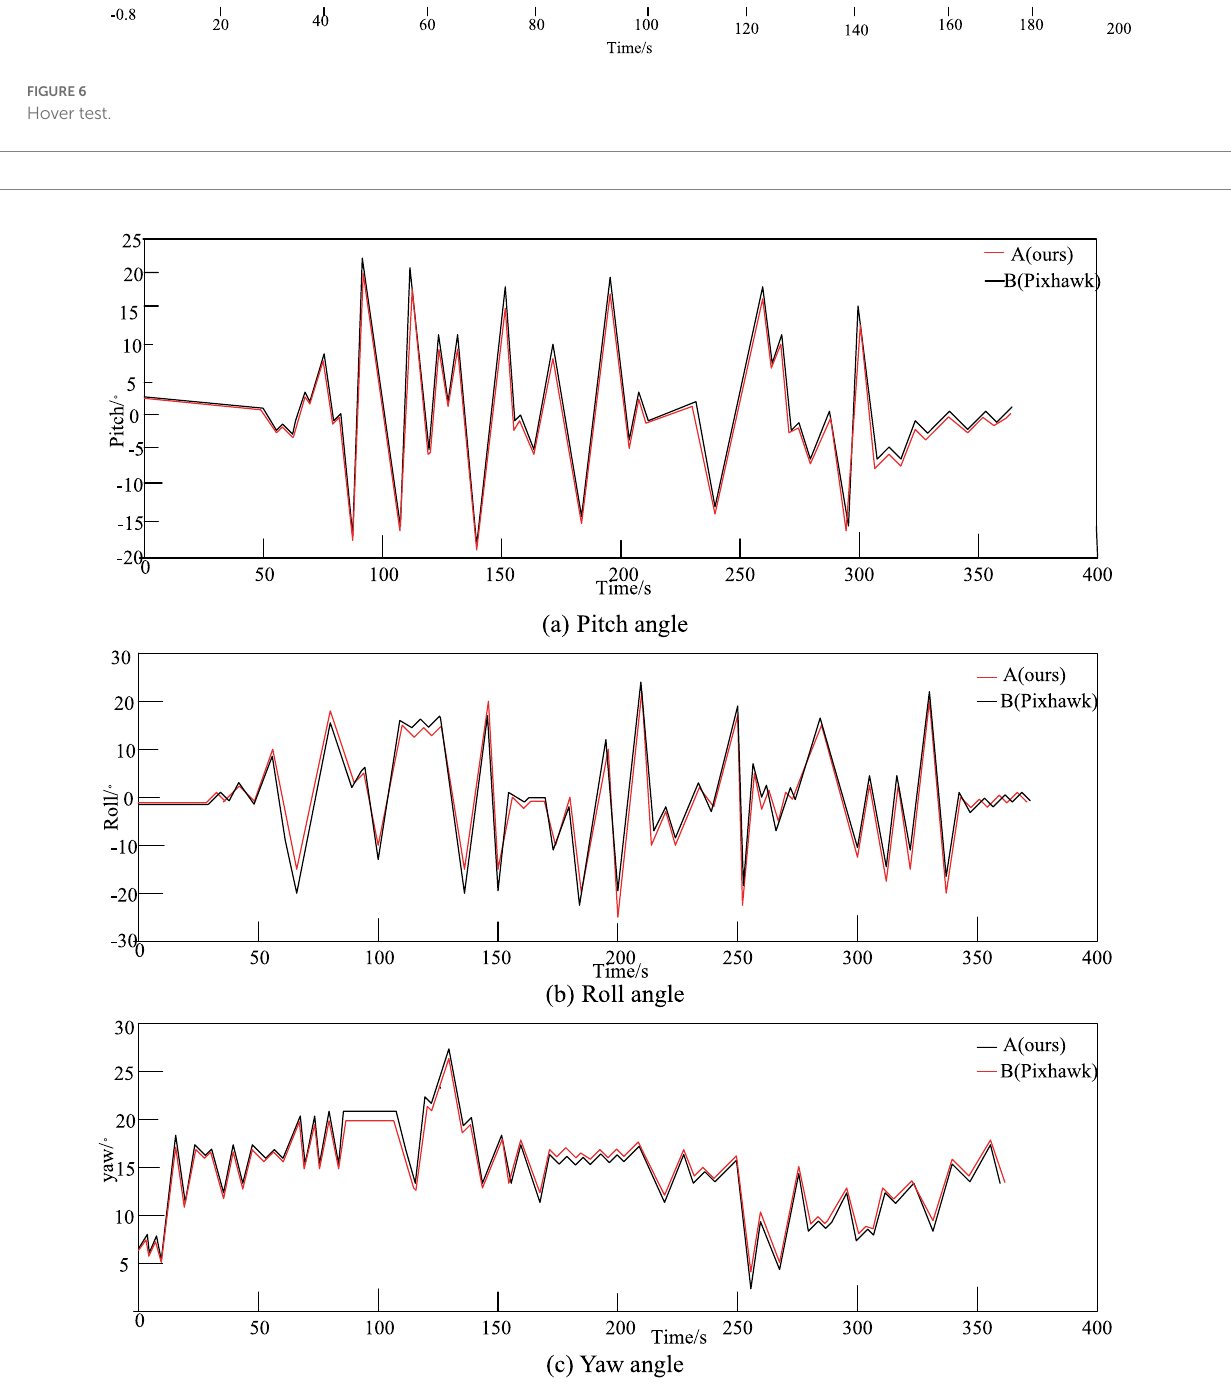
FIGURE 7 Angle comparison during pitch, roll, and yaw motion. (A) Pitch angle. (B) Roll angle. (C) Yaw